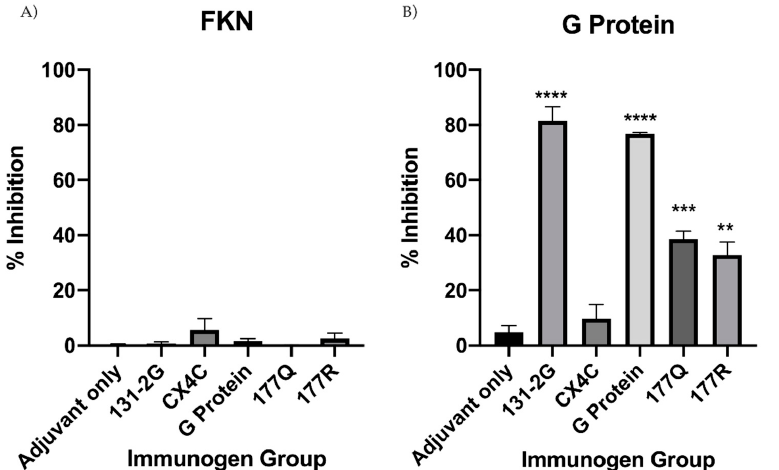
Figure 7. RSV G protein CX3C-CX3CR1 binding is inhibited by serum IgG from G protein immunogen vaccinated mice. Purified serum IgG from G protein immunogen or adjuvant vaccinated mice was examined for the ability to inhibit ( A ) FKN or ( B ) G protein CX3C binding to CX3CR1. IgG was co-incubated with FKN or G protein and 5 µ g/mL heparin to block non-specific binding. Ligand-specific binding and percent inhibition was determined by: [1 − (% Alexa Fluor-488+ CX3CR1.293 + cells treated with ligand + antibody mixture) / (% Alexa Fluor-488+ CX3CR1.293 cells treated with ligand + normal mouse IgG)] × 100, as previously described. Bars represent mean of at least three independent experiments + SEM. Analysis by one-way ANOVA compared to adjuvant-only control where, ** p < 0.01, *** p < 0.001 **** p < 0.00001.